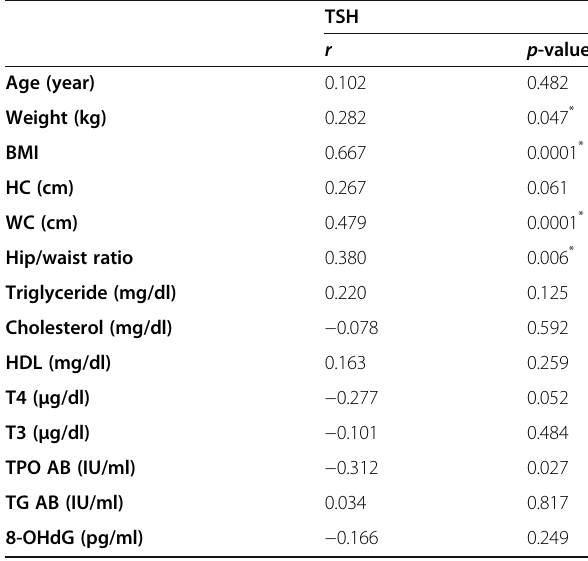
Table 3 Correlation of clinical data, thyroid function, lipid profile, oxidative DNA damage, and thyroid-stimulating hormone level in children with